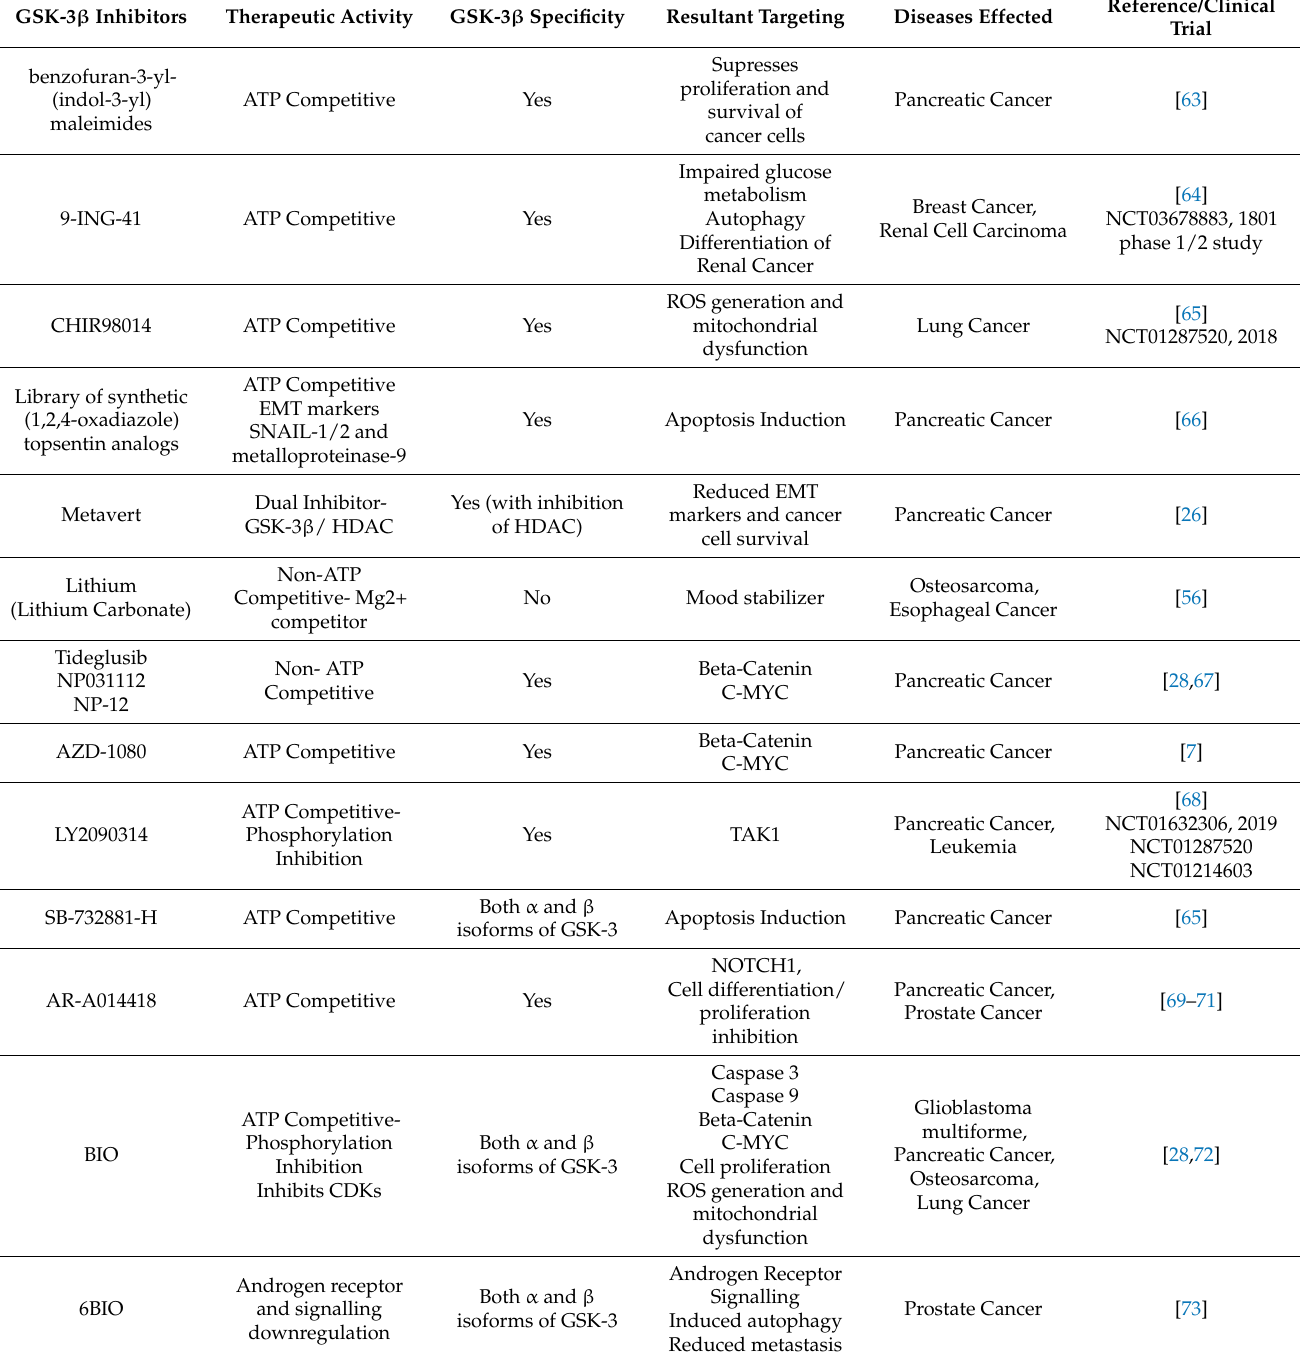
Table 1. Inhibitors of GSK-3 β in Cancer